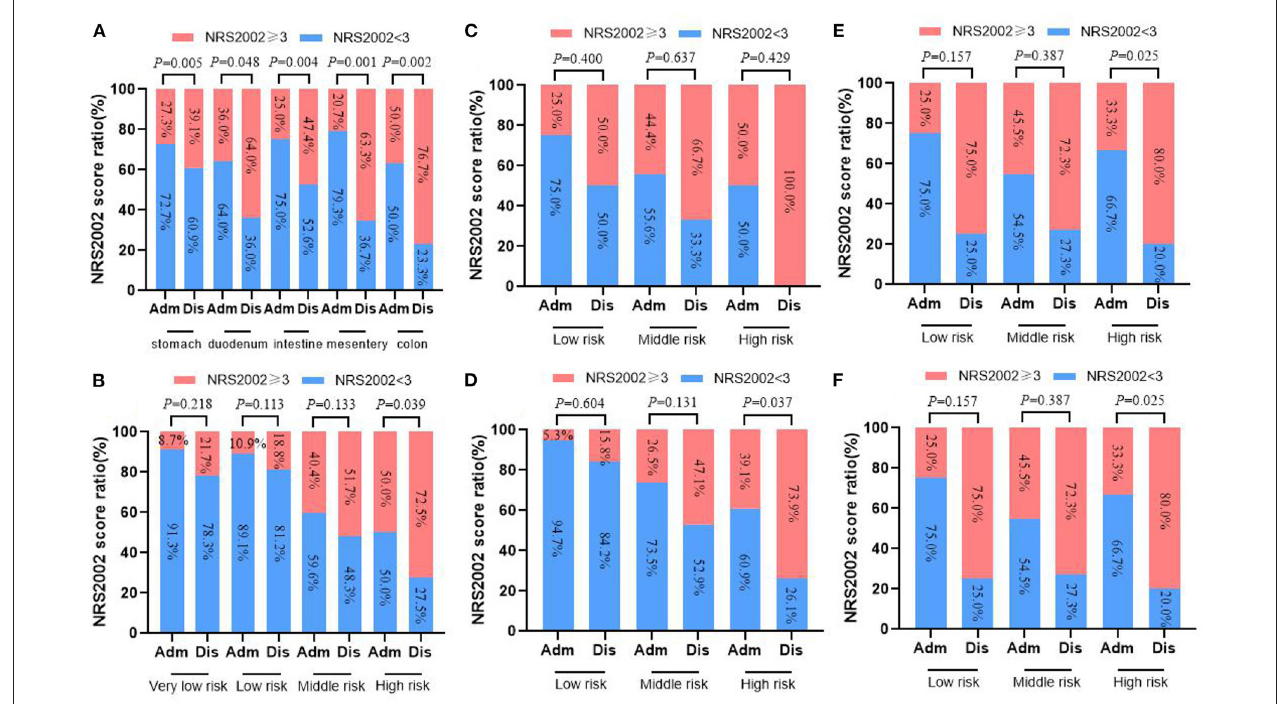
FIGURE 2 | Changes of NRS2002 screening at admission and discharge in 413 GIST patients. (A) Total; (B) stomach; (C) duodenum; (D) intestine; (E) colorectal; (F) mesentery.